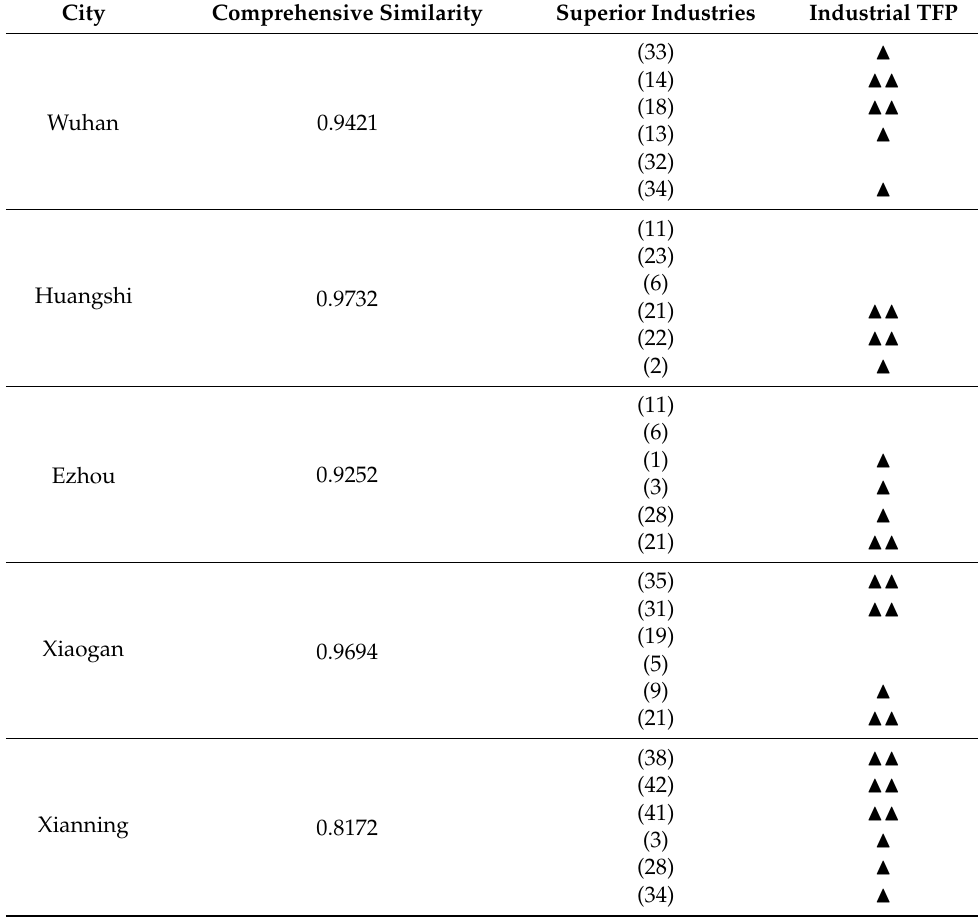
Table 2. Calculation results of the